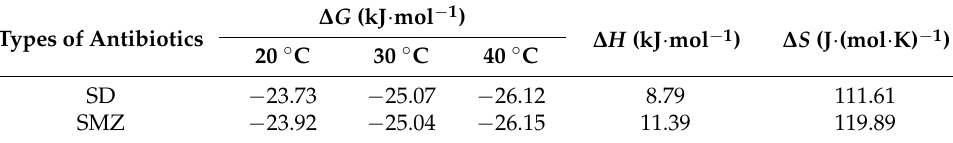
Table 4. Thermodynamic parameters of sulfonamide adsorption by ATP/BC-0.1. Types of Antibiotics